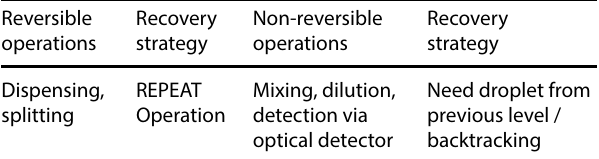
Table 6 Recovery strategies for various DMFB operations